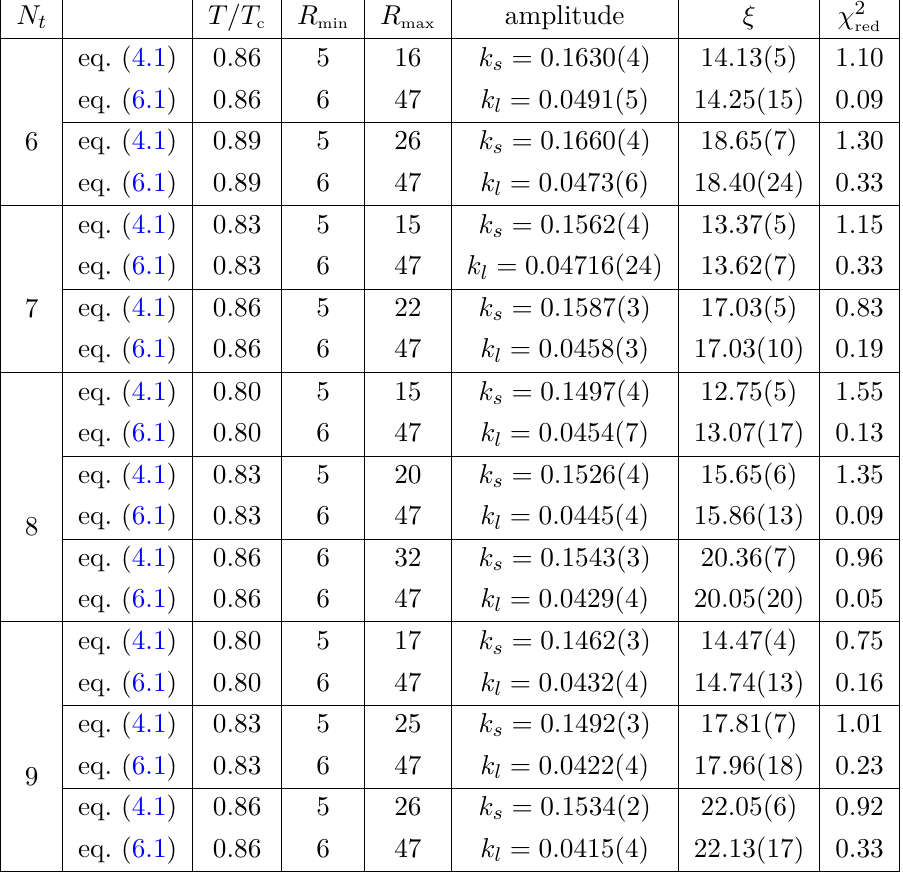
Table 3 . Results of the fits to the short- and long-distance behavior, according to the Svetitsky- Yaffe mapping, of the Polyakov-loop correlator for different values of β and N